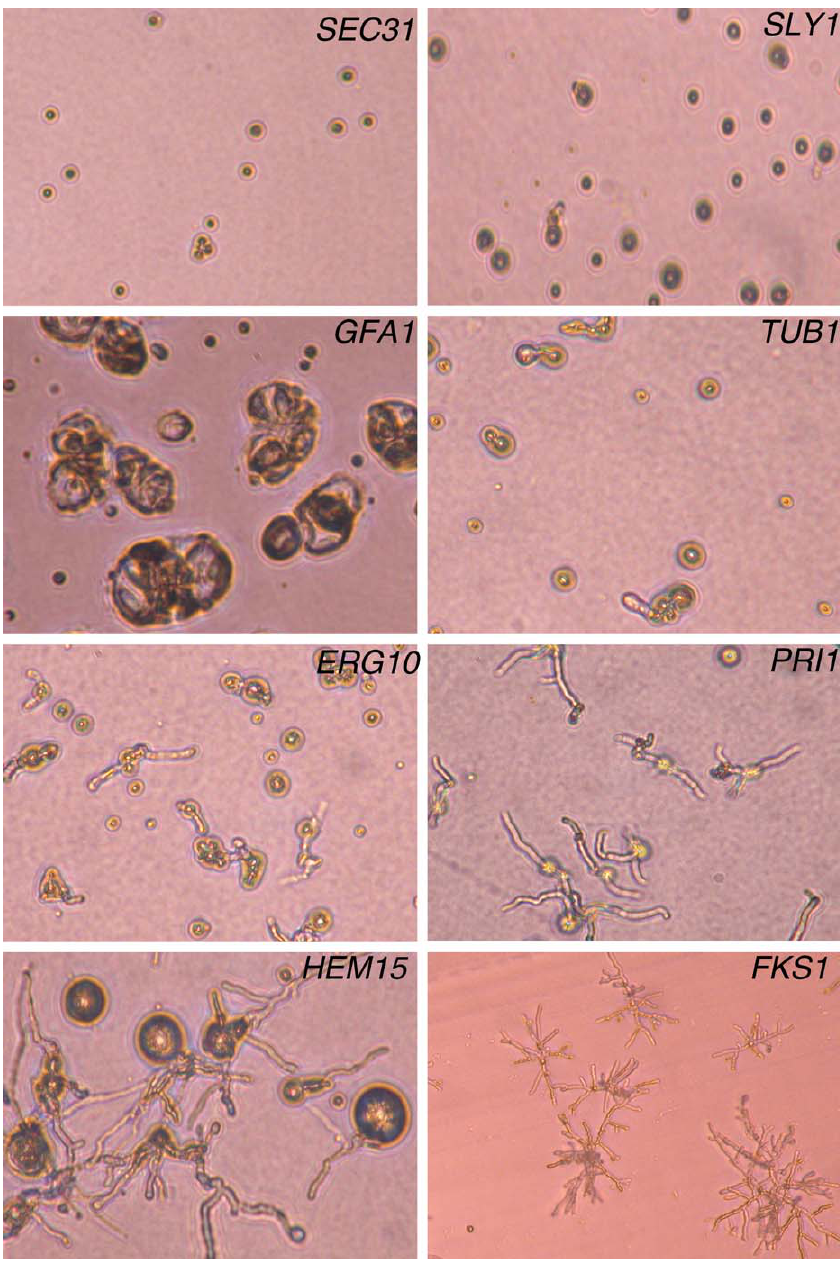
Figure 4. Analysis of p NiiA -CPR Associated Morphological Terminal Phenotypes Terminal growth phenotypes of p NiiA -CPR mutants were observed under a microscope ( 3 160) with conidia grown for 36 to 40 h at 30 8 C under standard repressing conditions. A continuum of conidia germination phenotypes of high penetrance was observed; ranging from those completely failing to undergo polarized growth (SEC31, SLY1) or swollen and highly disorganized condidia (GFA1), to those displaying stunted (TUB1, ERG10) or nonbranching germlings with swollen conidia (HEM15) with only rudimentary polarized growth. Micromycelial colonies were observed for a p NiiA - FKS1 mutant and resembling the morphology of wild-type A. fumigatus when grown in the presence of minimum effective concentration (MEC) of the FKS1p inhibitor, caspofungin [21]. Growth phenotypes under inducing conditions are shown in Figure